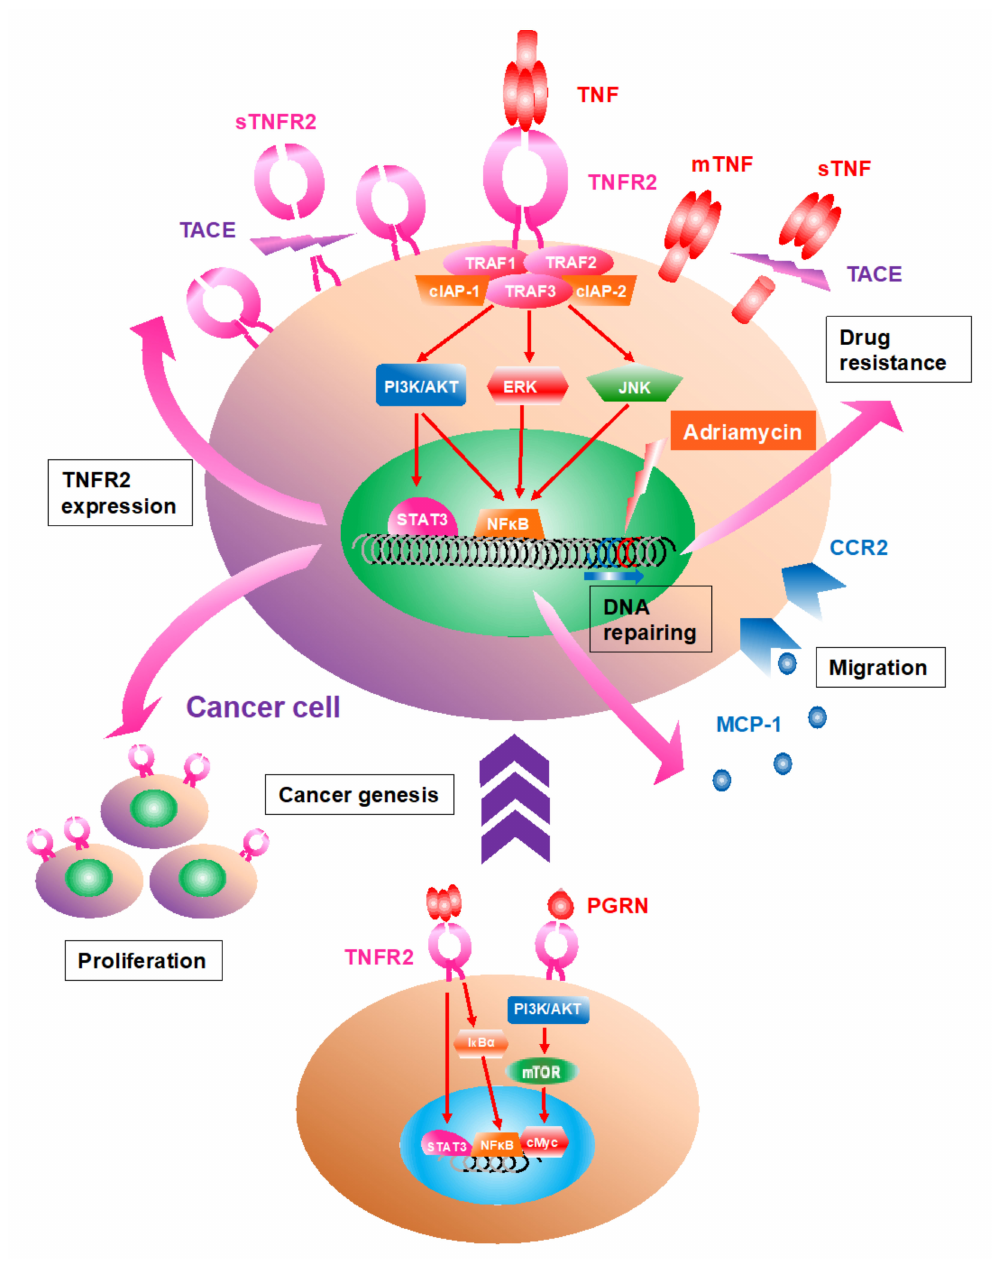
Figure 1. The roles of TNFR2 signaling within cancer cells. Many types of cancer cells express tumor necrosis factor receptor 2 (TNFR2) on their surface as well as trimeric membrane TNF, whose expression is also upregulated via TNFR2 signaling. After TNF binding, TRAF1/2/3 and clAP1/2 located on the intracellular domain of TNFR2 are clustered, activating further downstream pathways consisting of phosphatidyl inositol 3 kinase (PI3K)/AKT, mitogen-activated protein kinase (e.g., extracellular signal-regulated kinase, ERK; c-jun N-terminal kinase, JNK), nuclear factor- κ B (NF κ B), and signal transducer and activator of transcription 3 (STAT3). The activated TNFR2 signal facilitates proliferation and migration of the cancer cell as well as autocrine signaling by macrophage chemotaxis protein-1 (MCP-1) via the C-C chemokine receptor type 2 (CCR2), which drives the cancer cell to invade or migrate. Malignant transformation and tumorigenesis are induced via the signal; TNF or progranulin (PGRN) binding to TNFR2 activates I κ B α and NF κ B or PI3K/AKT/mammalian target of rapamycin (mTOR) and cMyc. The colitis-associated carcinogenesis is also developed by NF κ B activation. In addition, TNF and TNFR2 are cleaved in their stem regions by TNF α -converting enzyme (TACE), resulting in their soluble forms, sTNF and